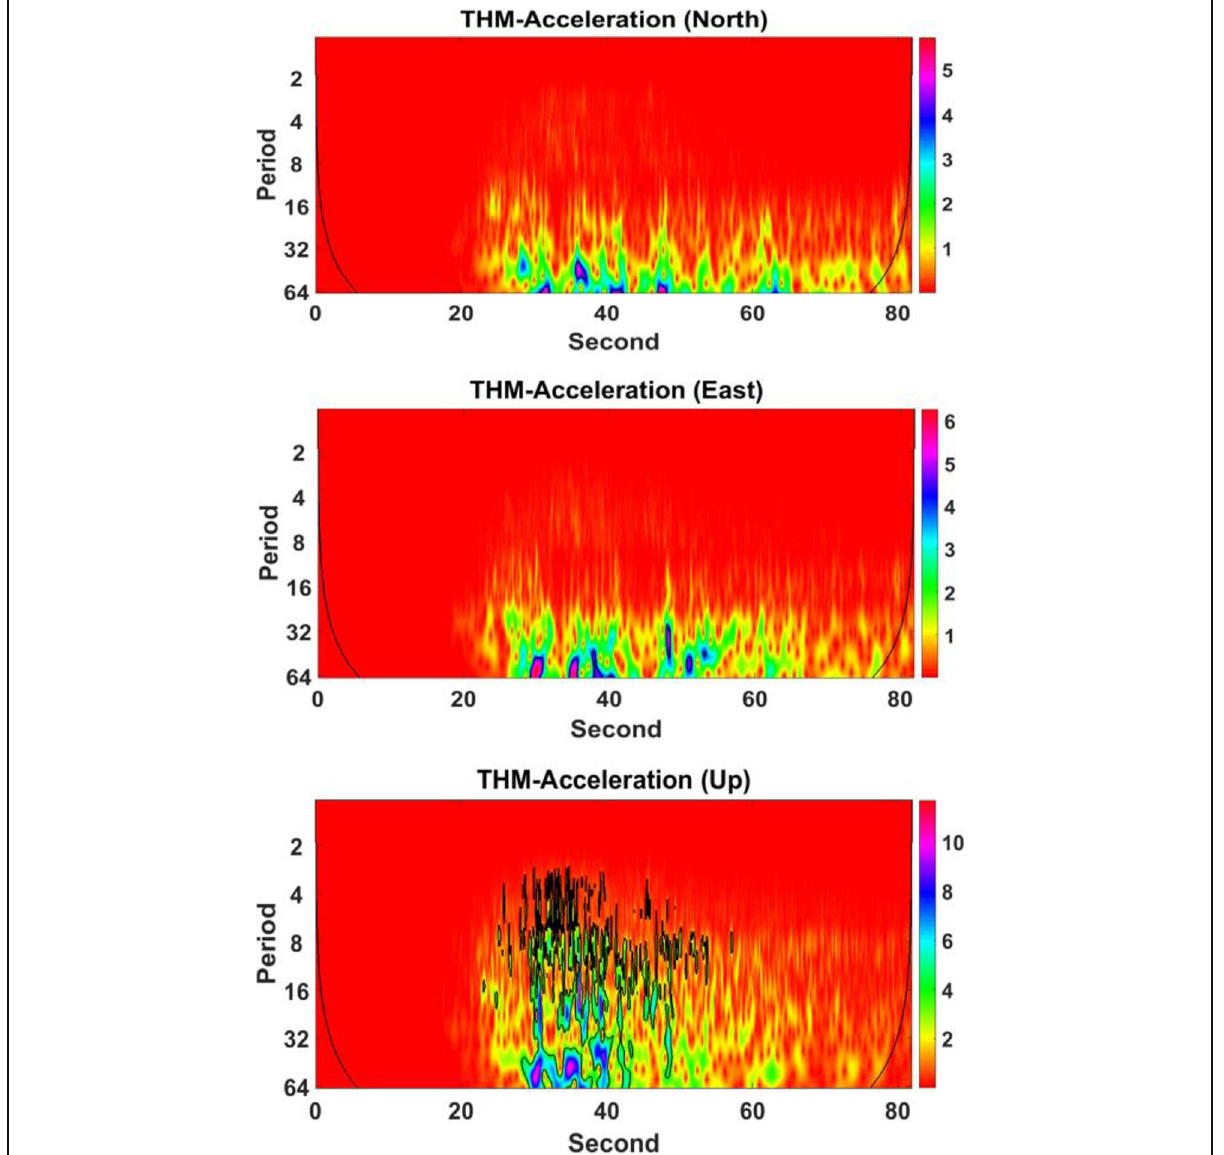
Fig. 9 Two Dimension CWT-Scalogram ground motion from NS, EW, and Vertical record (0 – 80 s) at THM